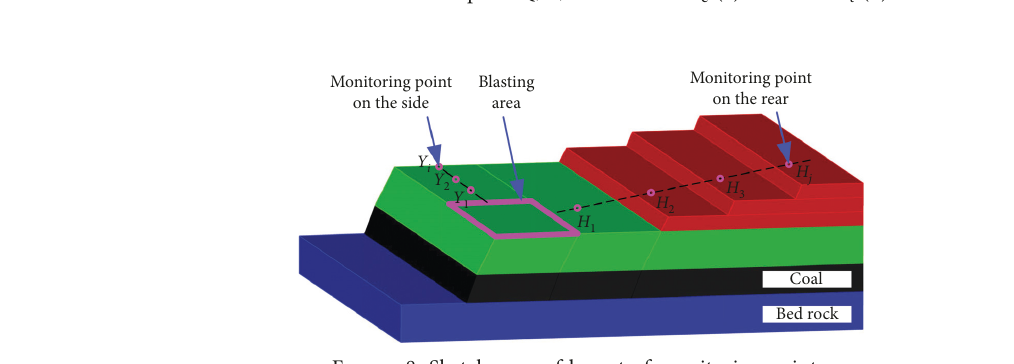
c (a) and with σ t (b).